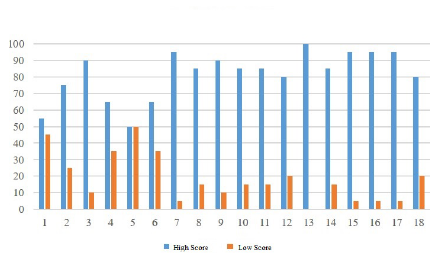
Figure 49. The result of preference.